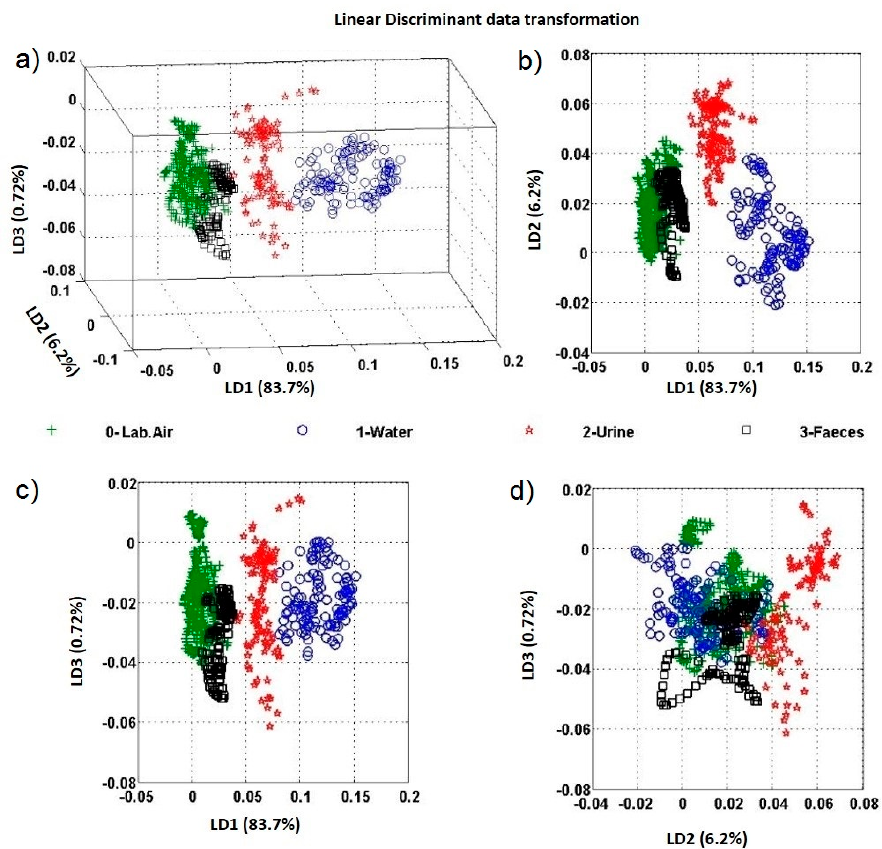
Figure 11. Linear discriminant analysis (LDA) of water, urine, and faeces probe measurement. ( a ) Shows the linear transformation of the raw data, which use the three largest discriminators (LD1, LD2, LD3), namely the eigenvectors with largest eigenvalues for the in-between-class and within-class scatter matrices. ( b – d ) show the LD1 vs. LD2, LD1 vs. LD 3, and LD2 vs. LD 3, respectively.